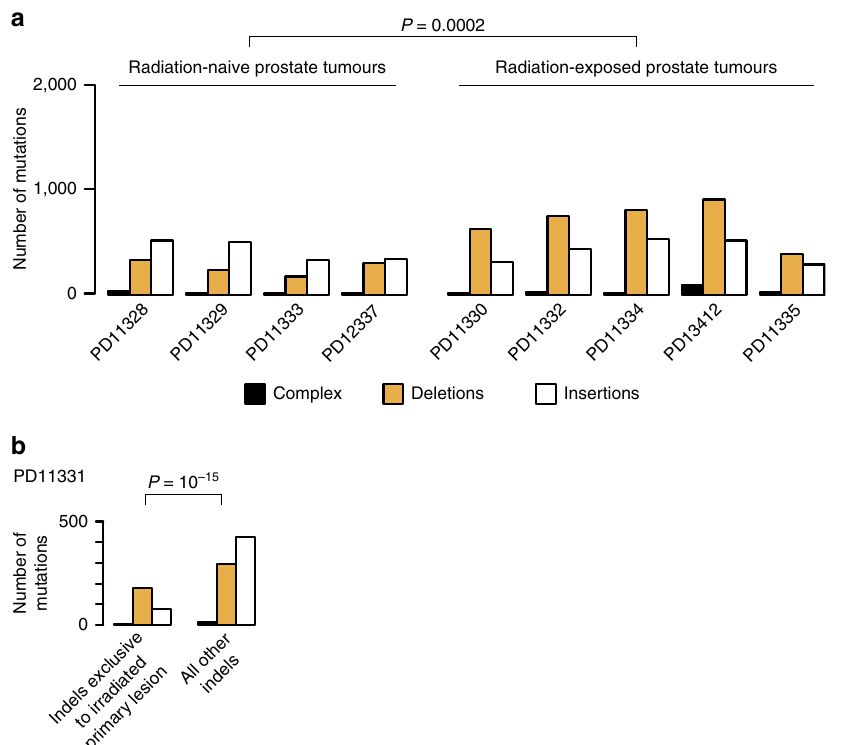
Figure 3 | Indels in prostate tumours. ( a ) Indels in radiation-naive versus radiation-exposed prostate tumours. Shown is the indel burden, by indel subtype, found in radiation-naive and in radiation-exposed prostate tumours. In radiation-exposed tumours radiotherapy had been administered to the primary tumour before formation of metastases. Deletions were significantly enriched in radiation-exposed tumours ( P ¼ 0.0002, generalized linear model). Note that radiation-associated tumours with confounding BRCA1 or BRCA2 deficiency were excluded from the statistical analysis (cases